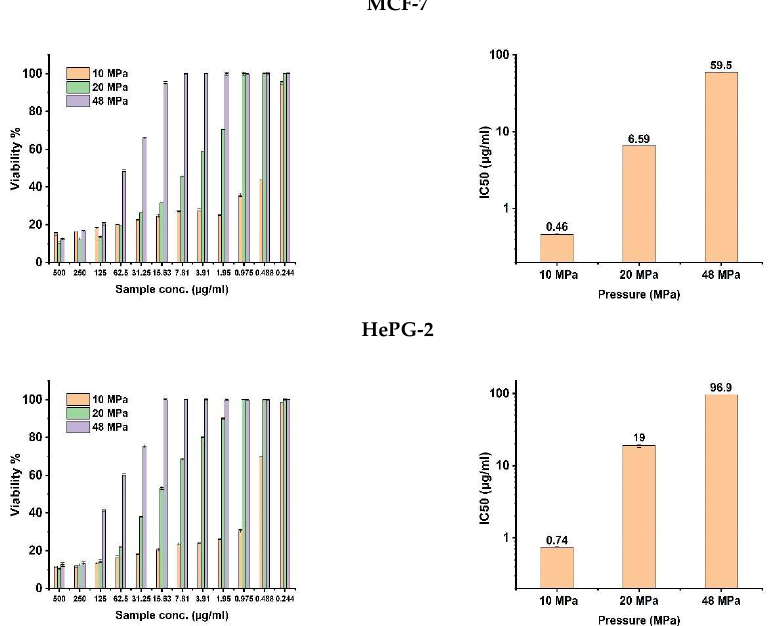
Figure 4. The antitumor activity of SFE extracts of S. costus at different pressures after 24 h of treatment against HCT, MCF-7, and HepG-2 cells (mean ± s. d, n = 3). ( A ). Viability %. ( B ). IC 50 value. The samples were also compared using the IC 50 values representing the sample effi- ciency as antitumor agents (Figure 4B). The best IC 50 values were recorded at E10 of about (0.44, 0.46, and 0.74) μg/mL against HCT, MCF-7, and HepG-2 cells, respectively. This was followed by 20 MPa with IC 50 (2.33, 6.59and 19.0) μg/mL, respectively, and IC 50 values at